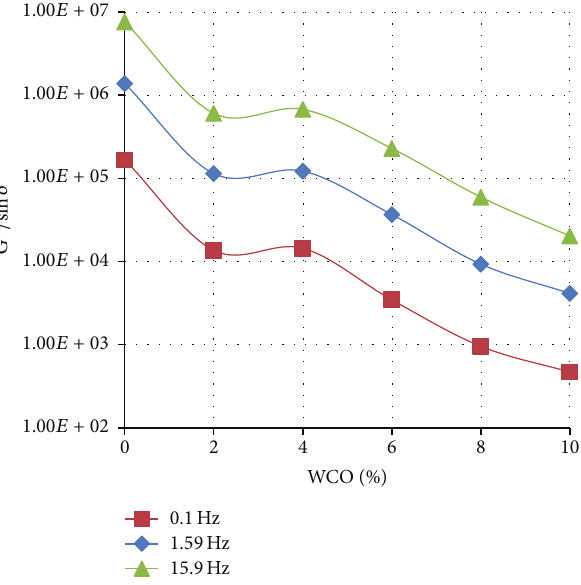
Figure 4: The variation of the rutting resistance parameter ( 𝐺 ∗ / sin 𝛿 ) with increasing concentration of WCO in TLA at various oscillating frequencies at 60 ∘ C.